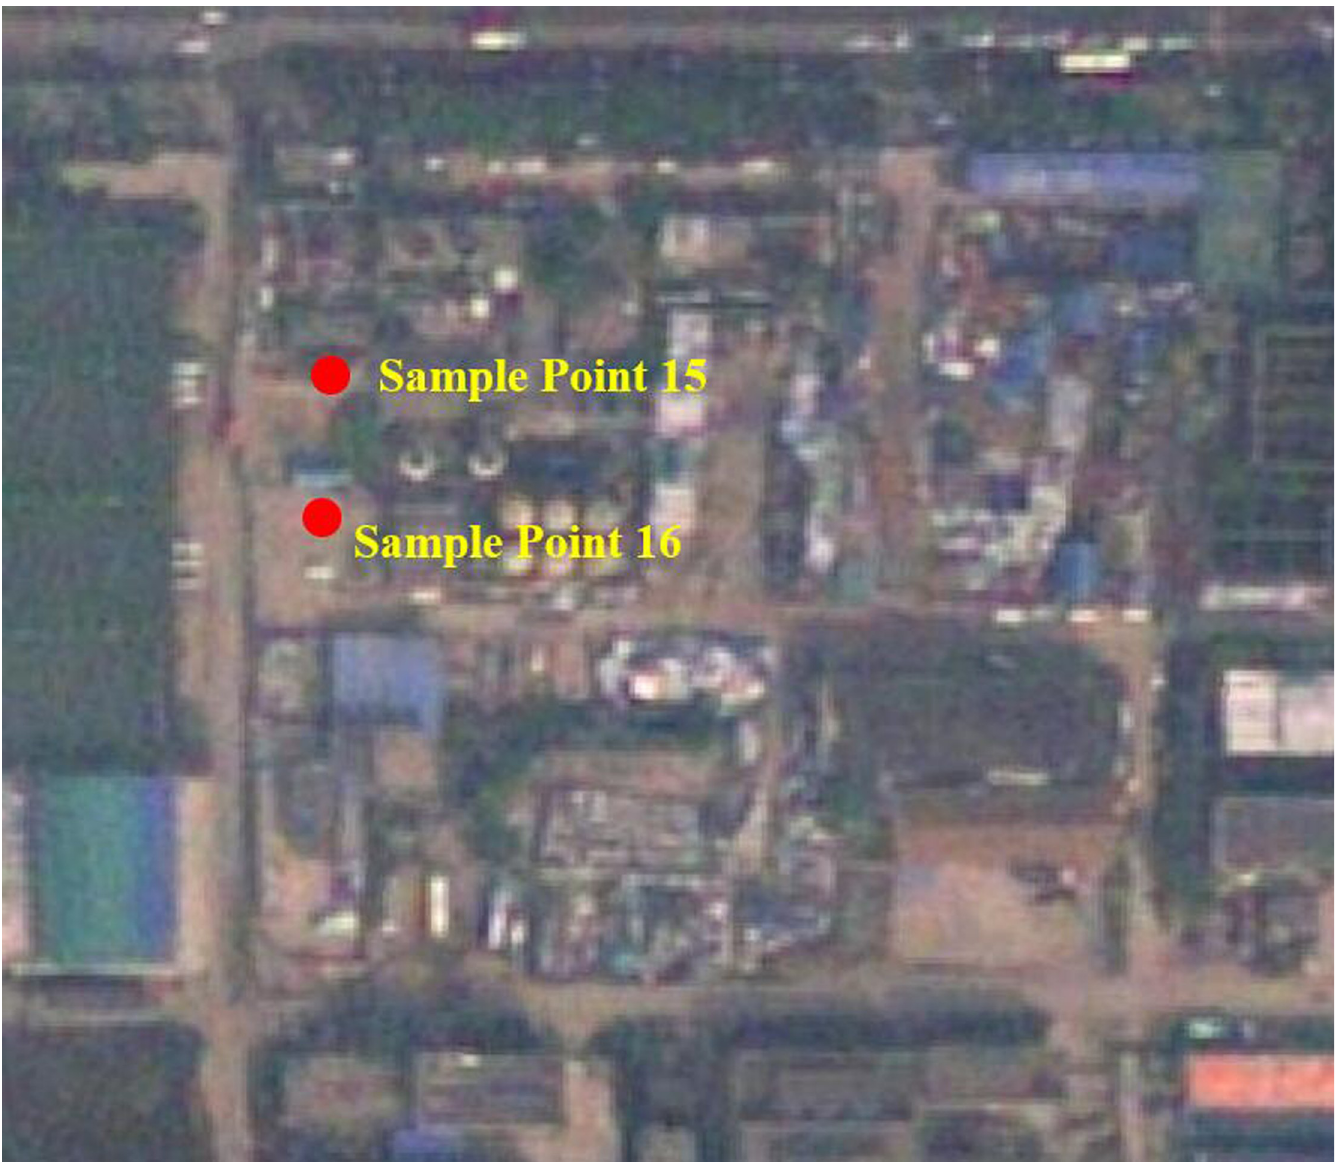
Fig 5. Satellite image of area C (The map was generated using free and open access data sources from National Platform for Common Geospatial Information Services. http://www.tianditu.gov.cn/).